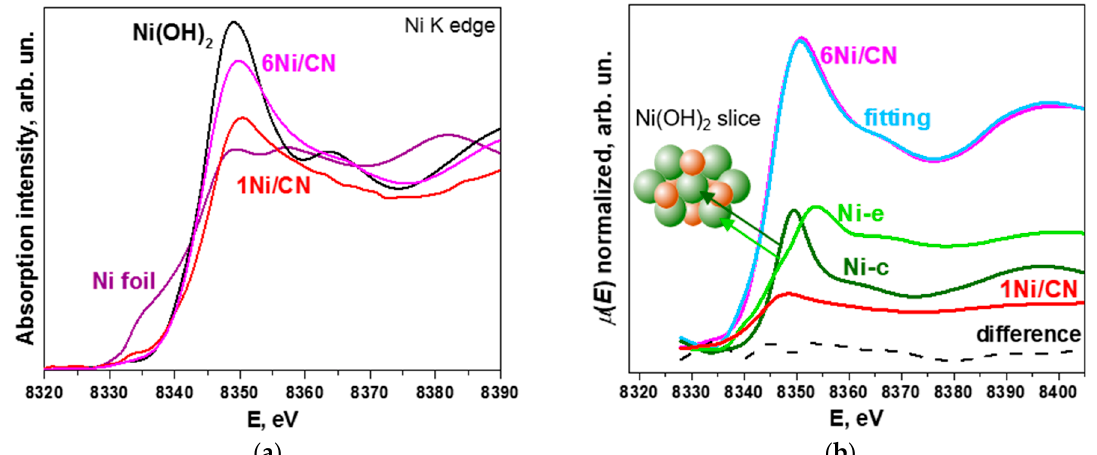
Figure 5. ( a ) XANES Ni K-edge spectra of 1Ni/CN and 6Ni/CN in comparison with Ni foil and Ni(OH) 2 reference spectra. The measurements were performed on samples after the catalytic reaction. ( b ) The fitting of the experimental Ni K-edge spectra of 6Ni/CN using a linear combination of the experimental spectrum of 1Ni/CN and the spectra simulated for the central Ni atom (Ni-c) and edge Ni atom (Ni-e) in Ni(OH) 2 . Dashed curve is the difference between experimental and synthetic spectra. Inset in ( b ) shows Ni(OH) 2 slice consisting of 7 Ni atoms (green) and 6 O atoms (red).